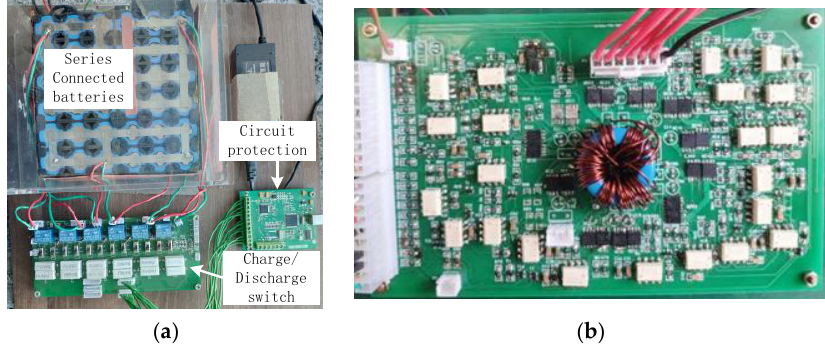
Figure 16. Experimental platform: ( a ) batteries platform; and ( b ) the proposed balancing circuit.